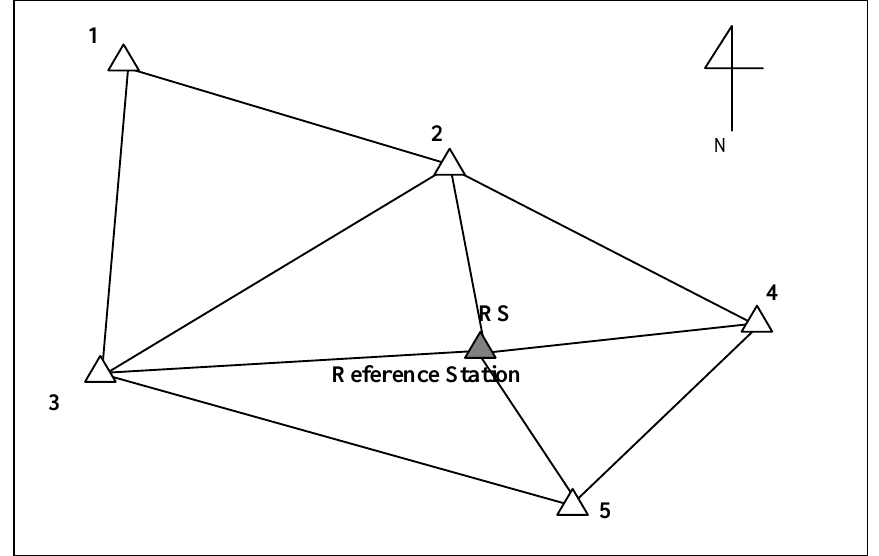
Figure 6 . Configuration of points in the network used in Test